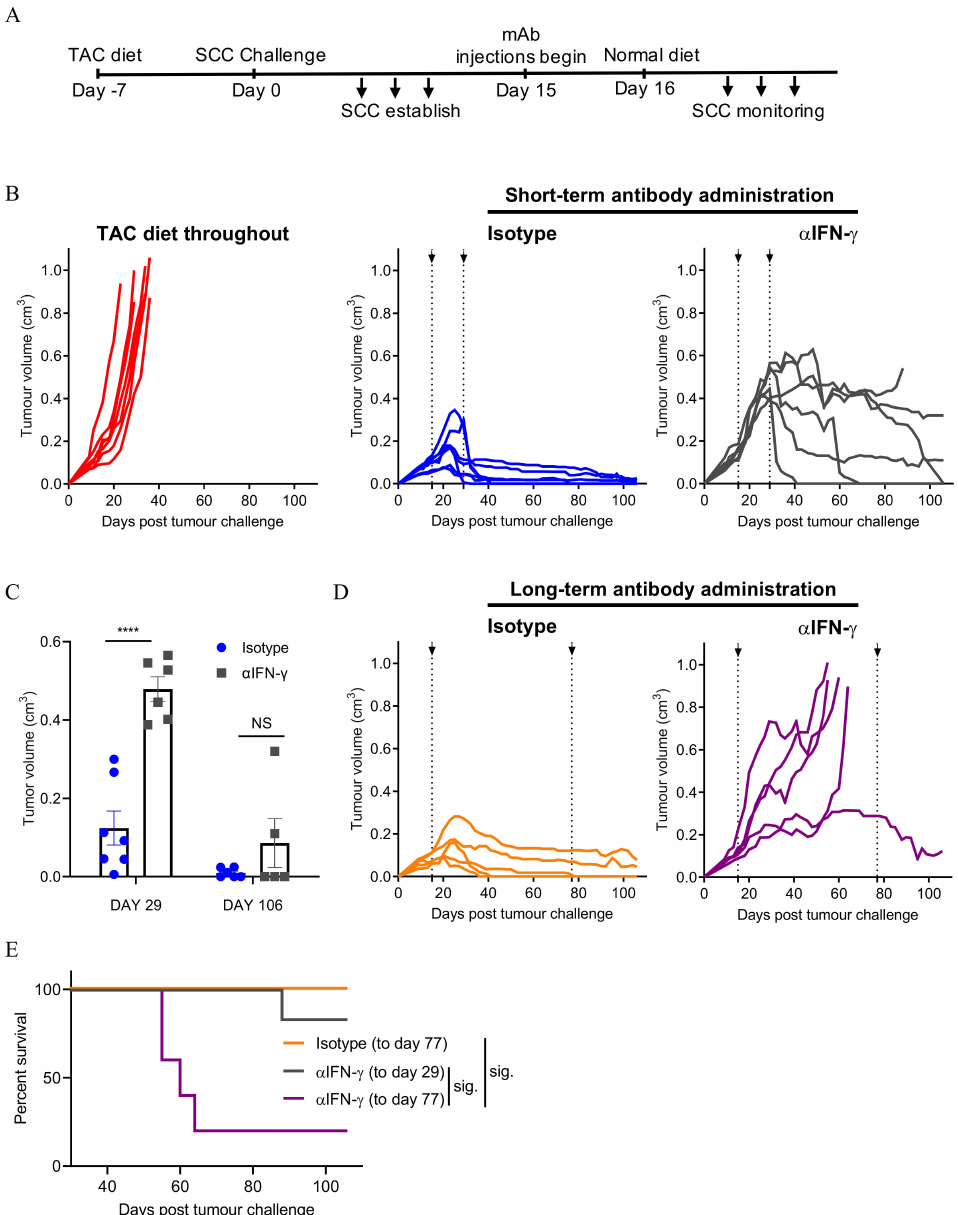
Figure 3. IFN- γ neutralisation abrogates SCC rejection. ( A ) Experimental schedule. ( B ) SCC growth pattern following short-term treatment with the indicated antibodies. Combined data from 2 independent experiments, individual tumour growth shown, n = 6–7/group. ( C ) Tumour volume during (Day 29) and after cessation (Day 106) of anti-IFN- γ treatment. Two-way ANOVA, bars represent mean ± SEM, data points represent individual mice. p < 0.0001 (****), ( D ) SCC growth pattern following long-term treatment with the indicated antibodies. Combined data from 2 independent experiments, individual tumours shown, n = 5/group. ( E ) Comparison of mouse survival in B and D. Survival analyses was performed by Log-rank (Mantel-Cox) test. Results then displayed as significant (sig.) after bonferroni-corrected multiple comparison test. Bonferroni-corrected threshold = 0.016, K = 3. Dotted lines in ( B , D ) indicate the period of antibody